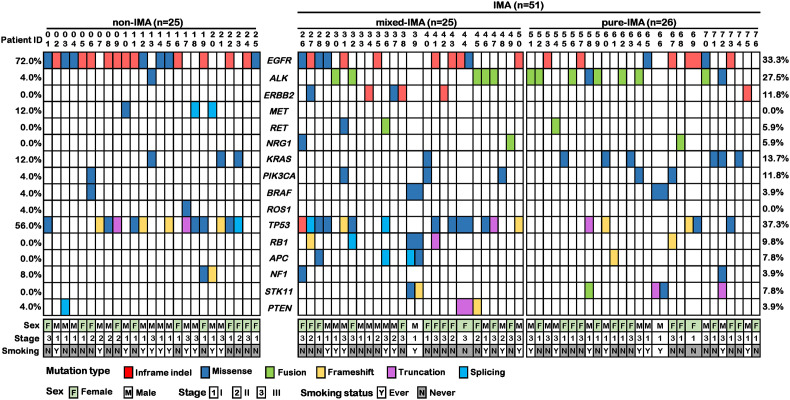
Co-mutation plot of common driver and suppressor genes in invasive mucinous adenocarcinoma (IMA) and non-IMA patients in our cohort. The mutation profile of 25 non-IMA patients and 51 IMA patients were shown. The IMA group could be further divided into mix-IMA (n=25) and pure IMA (n=26) based on the mucinous content of the tumor. Different colors indicate different mutational types. Clinical information on sex, TNM stage, and smoking history was shown at the bottom.